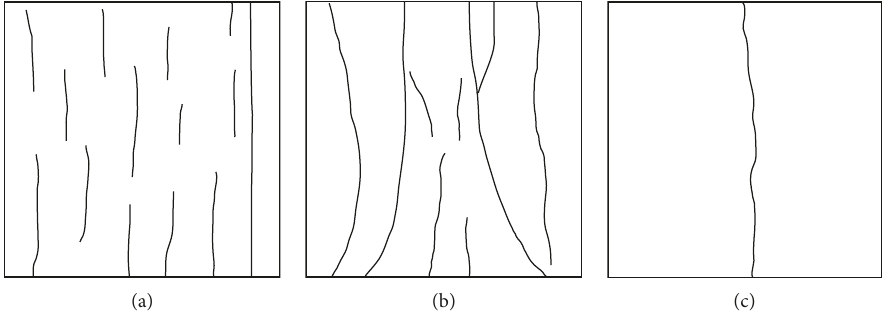
Figure 4: Failure modes of concrete under different loading modes. (a) Failure mode 1. (b) Failure mode 2. (c) Failure mode 3.